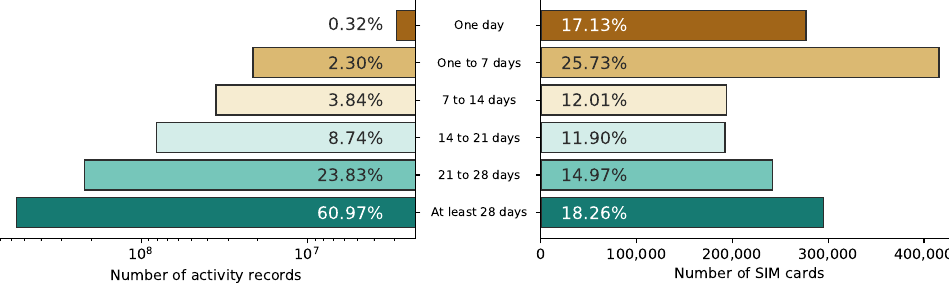
Figure 4. SIM card distribution of the “April 2017” data set, by the number of active days.